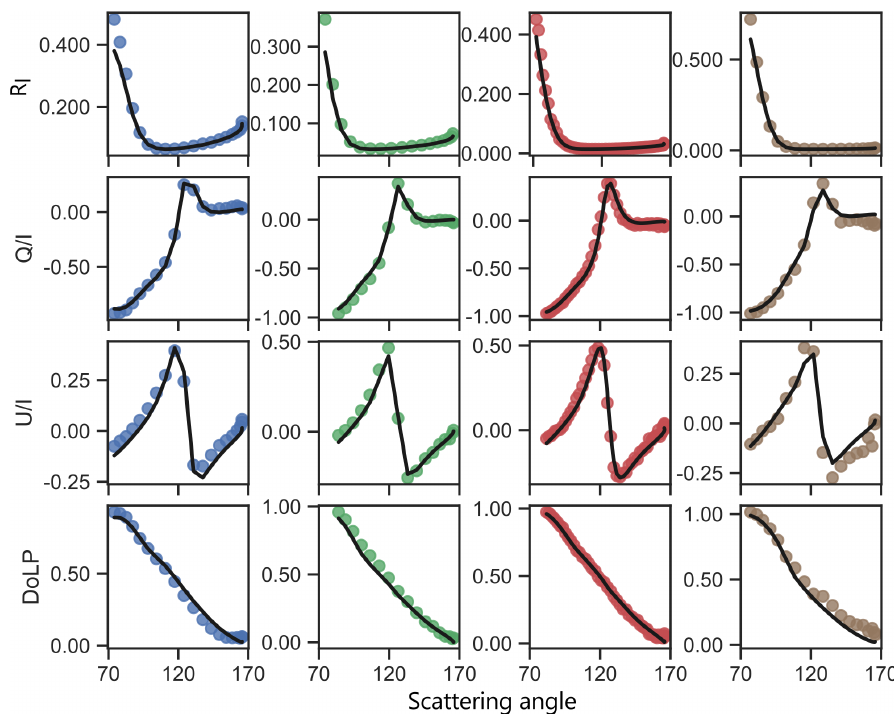
Figure 5. AirHARP-measured R I , Q/I , U/I , and DoLP (solid colored circles) for a single sunglint pixel from the scene in Fig. 4a and the GRASP fit to the measurements (black solid line) for all bands (blue – 440nm, green – 550nm, red – 670nm and brown – 870nm).